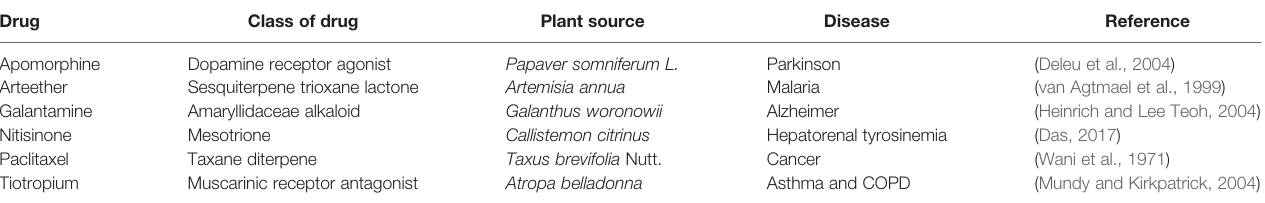
COPD, chronic obstructive pulmonary